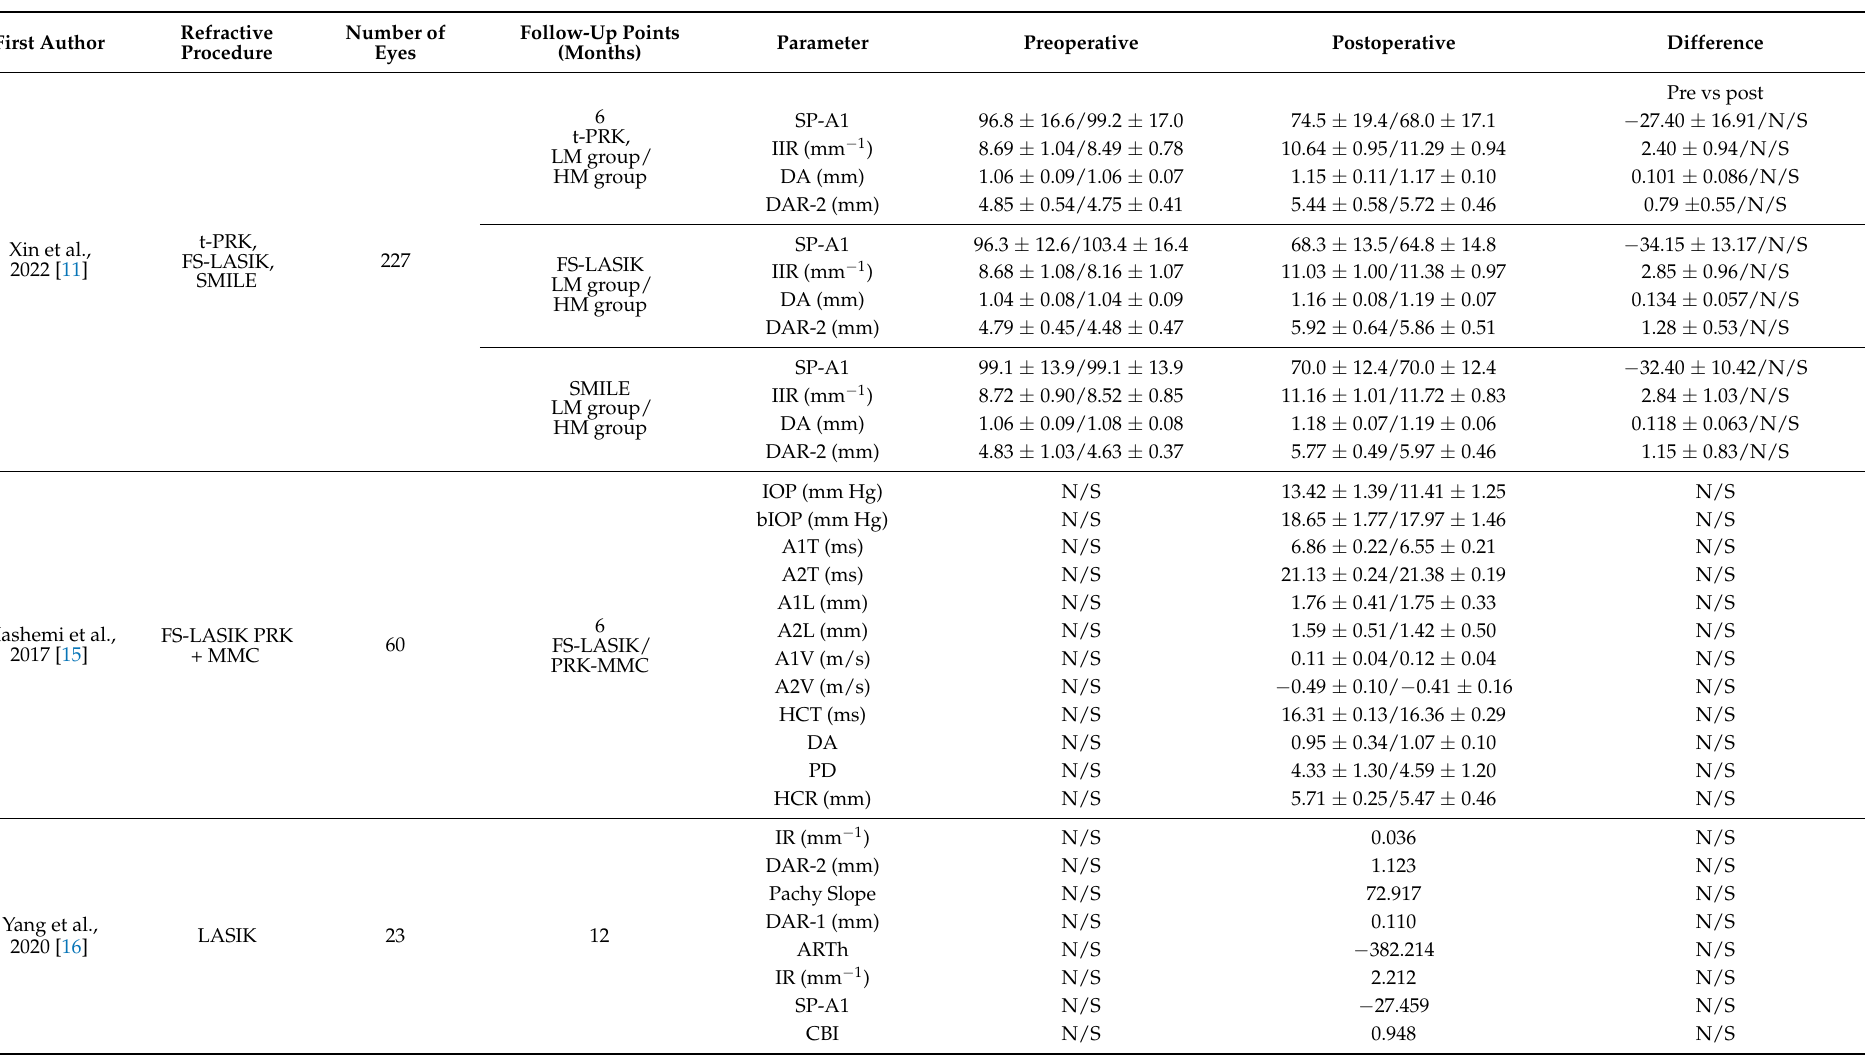
Table 3. Characteristics of corneal biomechanics assessed by Corvis-